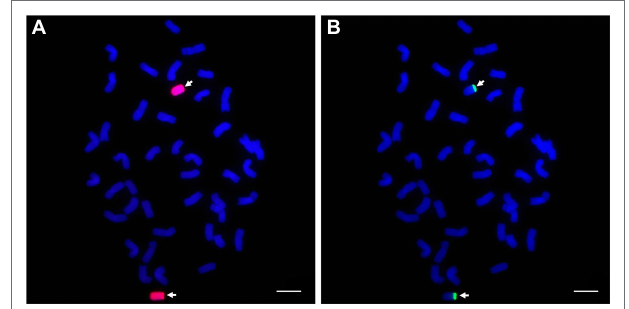
FIGURE 10 | GISH and sequential FISH identification of the wheat- P. huashanica ditelosomic addition line DT23. (A) P. huashanica genomic DNA was used as a probe for GISH (red). (B) FISH identification of DT23 using pPh37 (green). Arrows indicate the introduced P. huashanica chromosomes in DT23. Scale bar: 10 μ